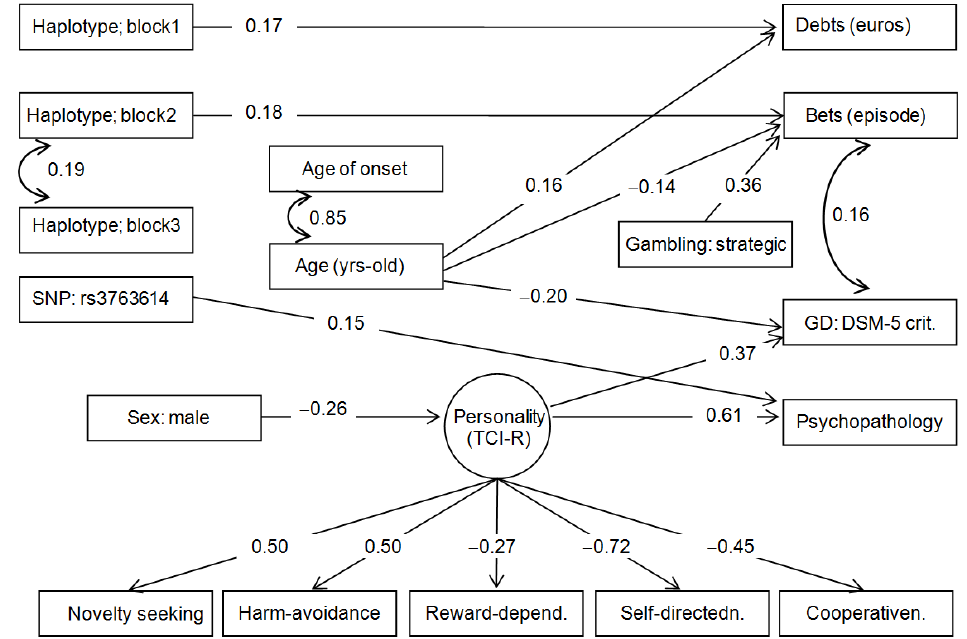
Figure 1. Path diagram: standardized coefficients ( n = 146). Note: Only significant parameter estimates were retained in the final model. SNP: single nucleotide polymorphism. GD: Gambling Disorder.